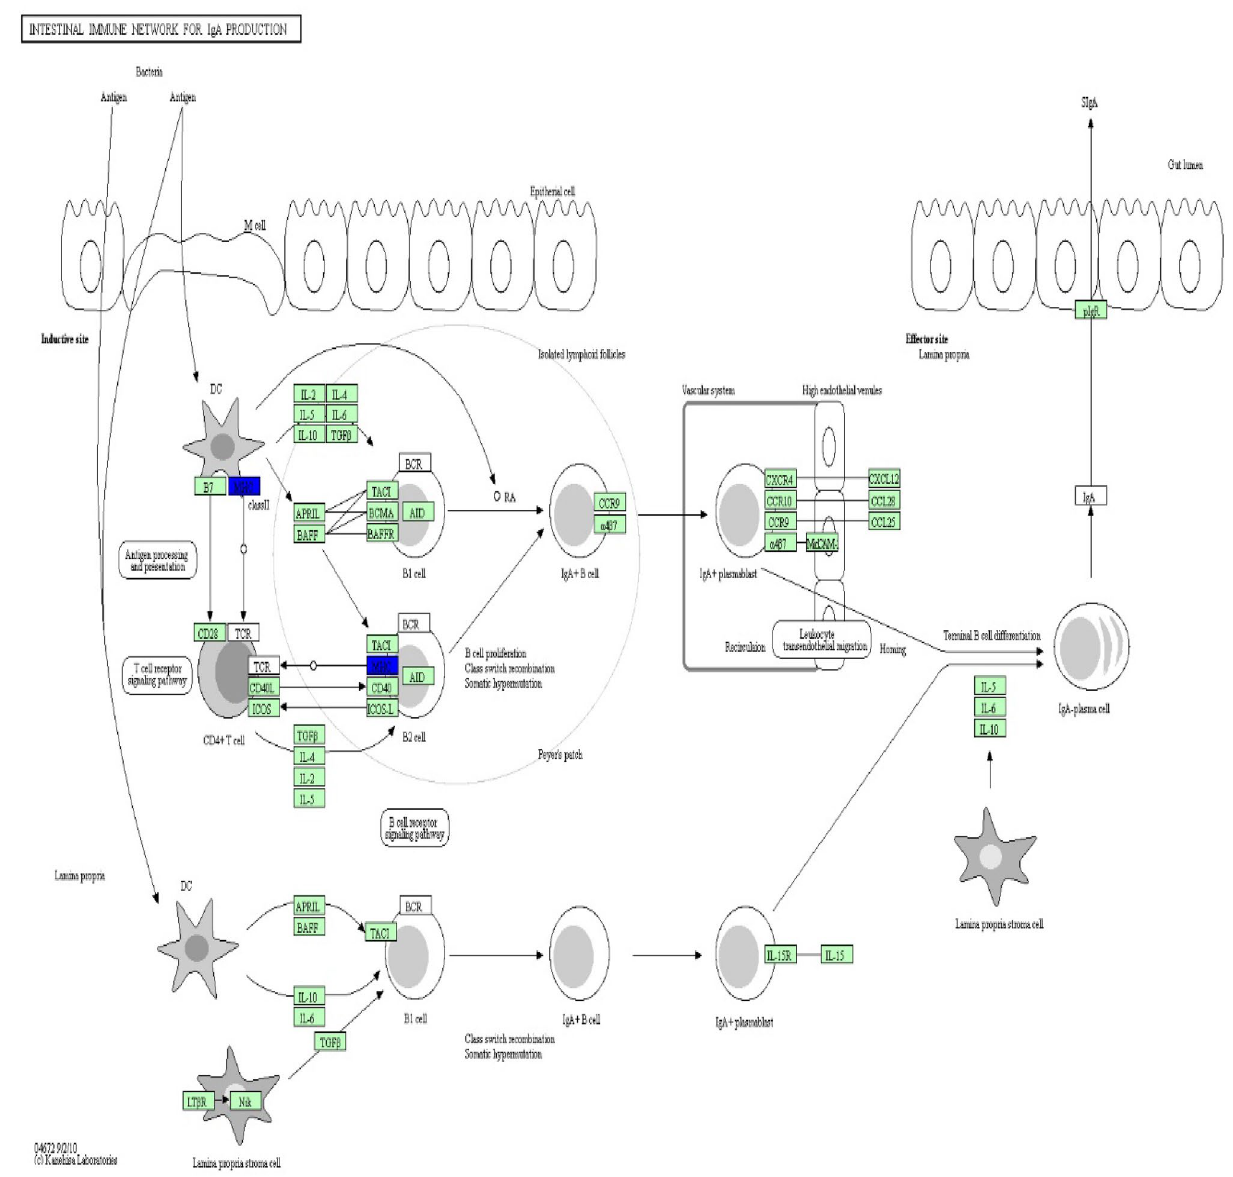
Figure 9. Differentially expressed genes involved in the intestinal immune network for IgA production in the spleen of two sheep breeds. The blue-labelled genes were significantly down-regulated ( p < 0.05). The green- labelled genes were expressed in both sheep spleens. KEGG pathway annotation was conducted using the DAVID website (http://david .abcc.ncifc rf.gov/) and searching the KEGG FCER1G , CSF1R , LCP2 , MS4A1 , CD2 , CD48 , CD3D , CD3E , GZMB , DQB , and DOB ) existed in one interaction network related to hematopoietic cell lineage, natural killer cell mediated cytotoxicity, and the intestinal immune network for IgA production pathway, and four genes ( C2 , HP , C1s , and C4BPA ) existed in the network related to the complement and coagulation cascade pathway. C3 , HP , and C1s were up-regulated, and C4BPA was down-regulated. Validation of RNA‑seq results by RT‑qPCR. To validate the RNA-seq results, the expression fold changes (2 −ΔΔCt ) of 11 DEGs were measured via RT-qPCR (Fig. 11). These genes belong to divergent functional categories. The serum amyloid A protein ( SAA ) are associated with the extracellular region; eight genes, includ- ing lymphotoxin beta ( LTB ), complement C3 ( C3 ), CD48 antigen precursor ( CD48 ), Fc fragment of IgE receptor Ig ( FCER1G ), complement component 4 binding protein, alpha chain precursor ( C4BPA ), indoleamine 2,3-diox- ygenase 1 ( IDO1 ), G-protein coupled receptor 183 ( GPR183 ), and NADPH oxidase cytosolic protein p47phox ( p47phox ) are associated with immune system processes. Two genes, TYRO protein tyrosine kinase-binding protein ( TYROBP ) and interferon-induced transmembrane protein 1 (9–27) isoform 1 ( IFITM1 ) are associated with membrane. The expression of 10 genes ( LTB , SAA , C3 , CD48 , TYROBP , FCER1G , IFITM1 , C4BPA , IDO1, and p47phox ) obtained by RT-qPCR was similar to RNA-seq. The expression of GPR183 found by RT-qPCR